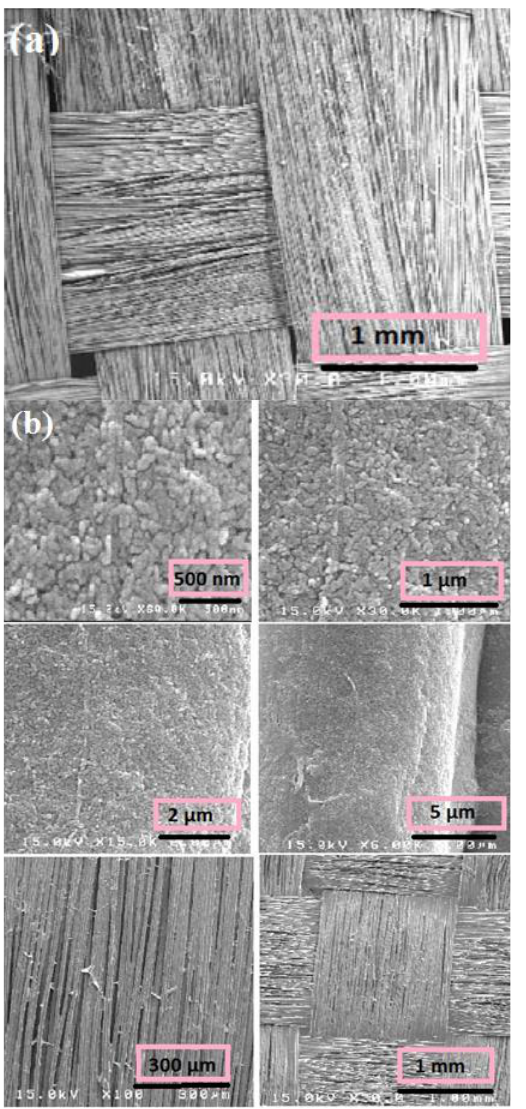
Fig. 7. SEM micrograph of the un-coated Kevlar fabric (a) and the three-layers (PAB-A, Bo-E and St-A) coated Kevlar fabric (b) at different magnifications.